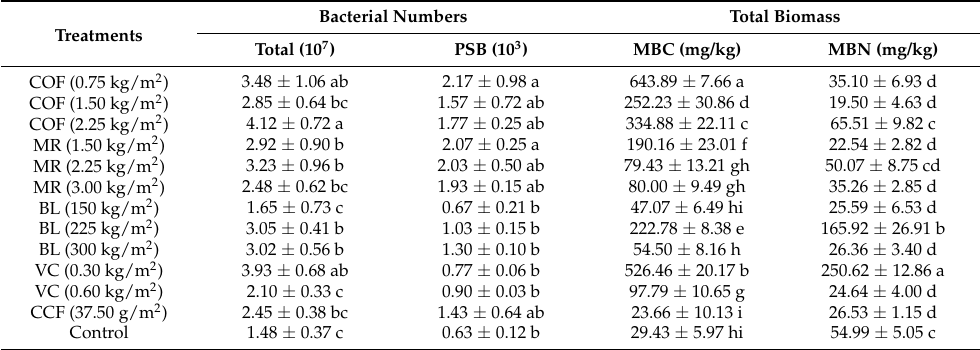
Table 4. Effect of different biological organic and chemical fertilizer on bacterial numbers and total biomass in new reclamation soil.